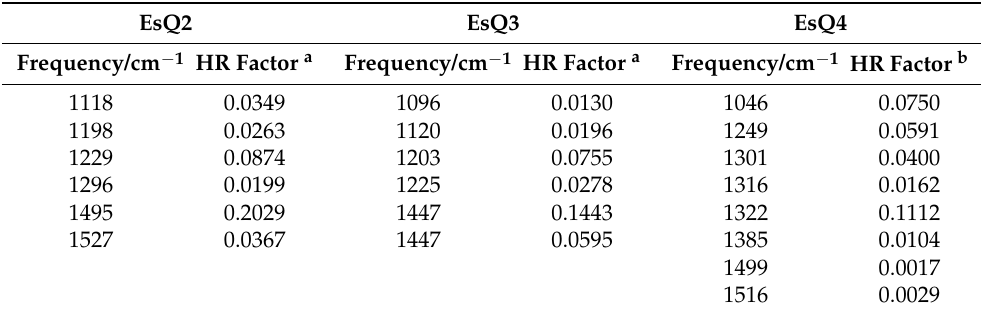
Table 3. Computed HR factors for the optically active transition of EsQ2, EsQ3 and EsQ4 .